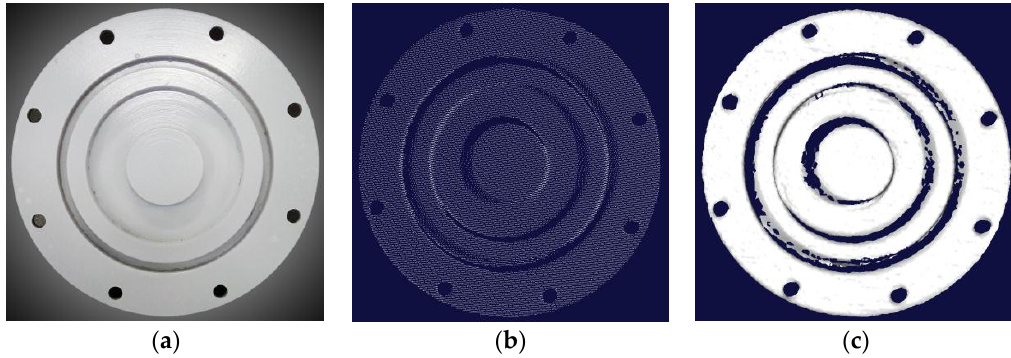
Figure 11. Measurement for a sealing cover of an underwater instrument. ( a ) Photograph; ( b ) Surface point cloud; ( c ) Triangular mesh representation.